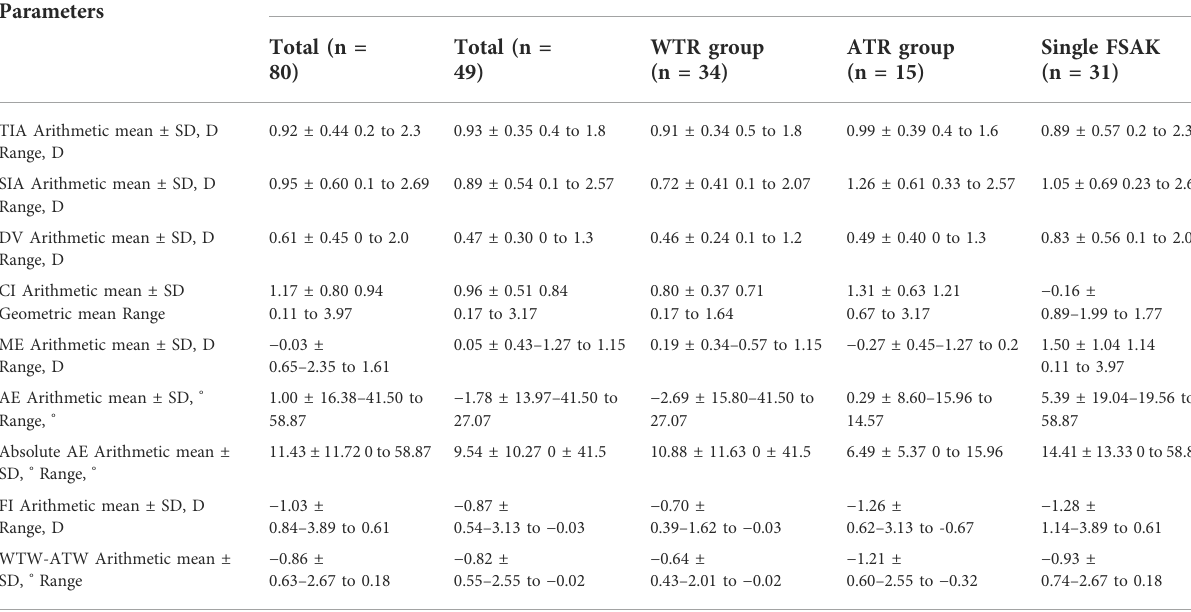
TABLE 3 Vector analysis of keratometric astigmatism after femto Z8 FLACS and FSAK using the alpins method. Vector Analysis Parameters